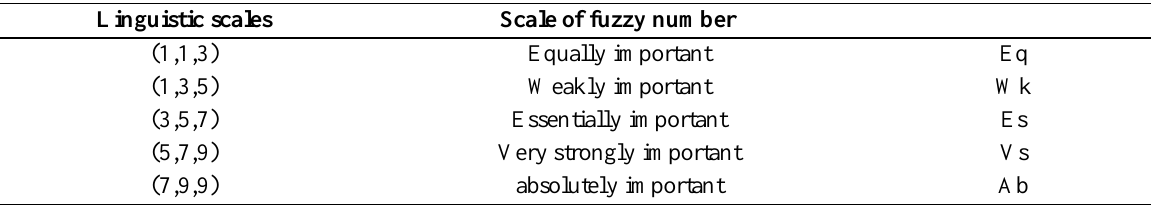
Table 4. Linguistic scale for weight